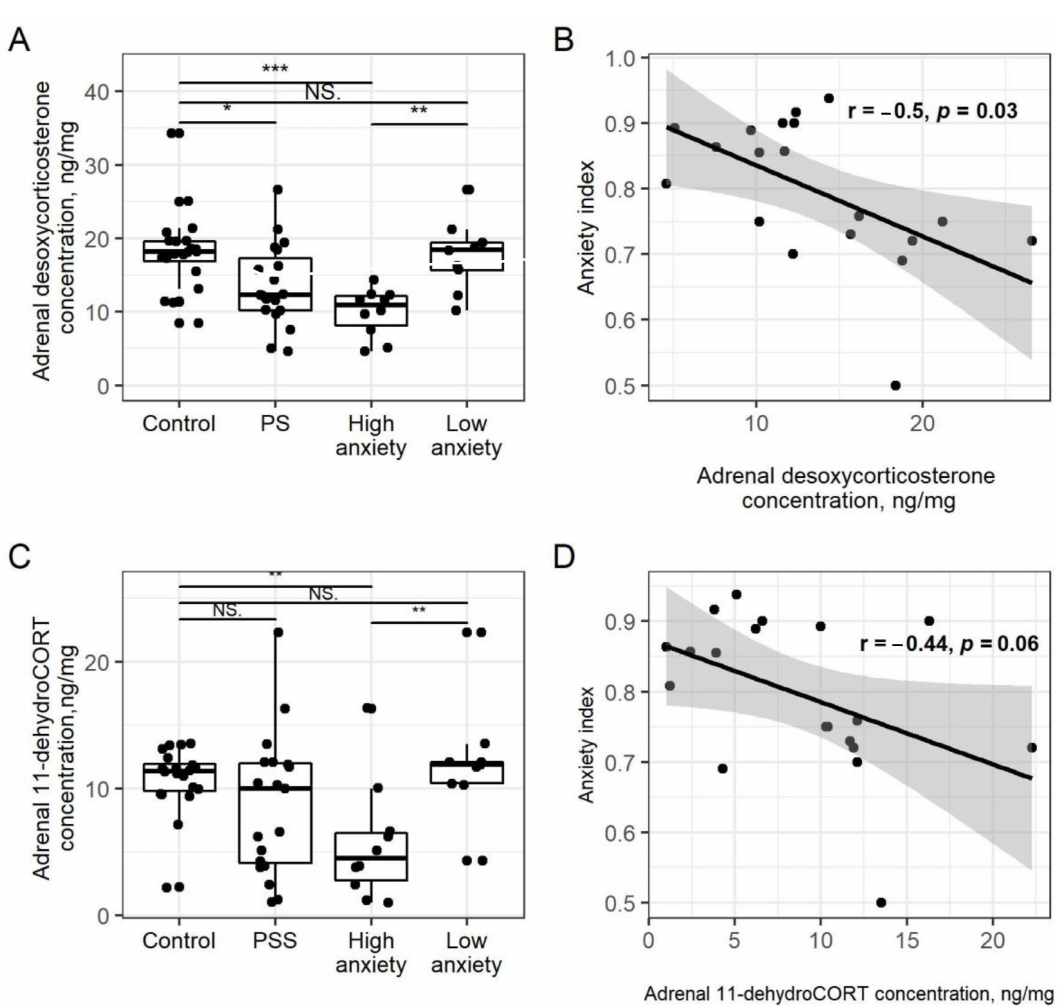
Figure 2. PSS causes a decrease in desoxyCORT and 11 - dehydroCORT . Panel ( A ). Adrenal desoxyCORT concentrations. Differences in adrenal desoxyCORT concentrations among groups are shown as boxplots with dots rep-resenting individual data values and medians shown by horizontal lines. The boxes include the central 50% of the data, i.e., from the 25th to the 75th percentile. The whiskers include the data contained within 1.5 times the interquartile range. NS = p > 0.05; * p < 0.05; ** p < 0.01; *** p < 0.001. p values determined in non-parametric analysis. Panel ( B ). Spearman correlation between AI and adrenal desoxyCORT concentration in PSS rats. Gray area around the line represents the 95 % confidence interval. Panel ( C ). Differences in adrenal 11-dehydroCORT concentrations between groups. See Panel ( A ) legend for description of the plots. Panel ( D ). Spearman correlation between AI and adrenal 11-dehydroCORT concentration in PSS